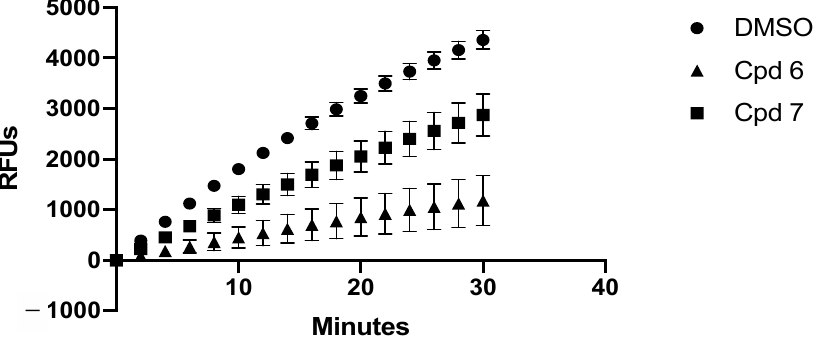
Figure 6. In-vitro mRNA degradation assay—Compounds 6 and 7 . Representative analogue inhibition of in-vitro RnpA-mediated RNA degradation. DMSO or 62.5 µM of the compound was incubated with RnpA in the presence of the FRET RNA substrate for 30 min at 37 °C. Fluorescence measurements (RFUs) were collected every 2 min at excitation 490 nm, emission 520 nm.